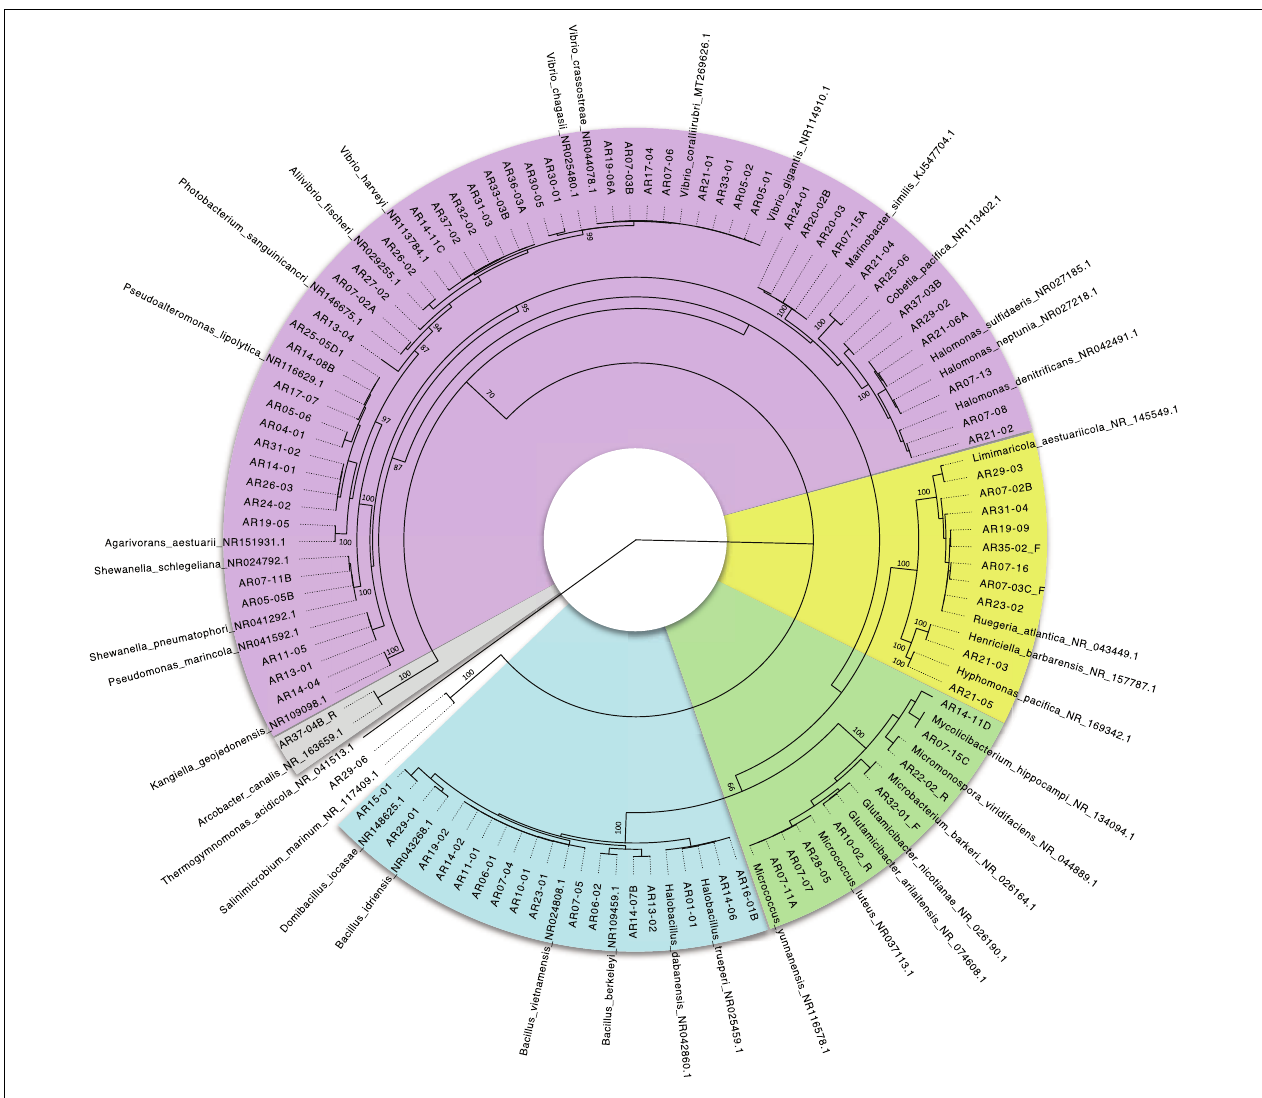
FIGURE 5 | Circular maximum-likelihood phylogenetic tree of isolated bacterial strains and their closest NCBI (BLAST) relatives based on 16S rRNA gene sequences. Bootstrap values calculated from 1000 replicates using maximum likelihood are shown the most representatives at their representative node. Colors indicate distribution by Classes: Epsilonproteobacteria (gray), Gammaproteobacteria (purple), Alphaproteobacteria (yellow), Actinobacteria (green), and Bacilli